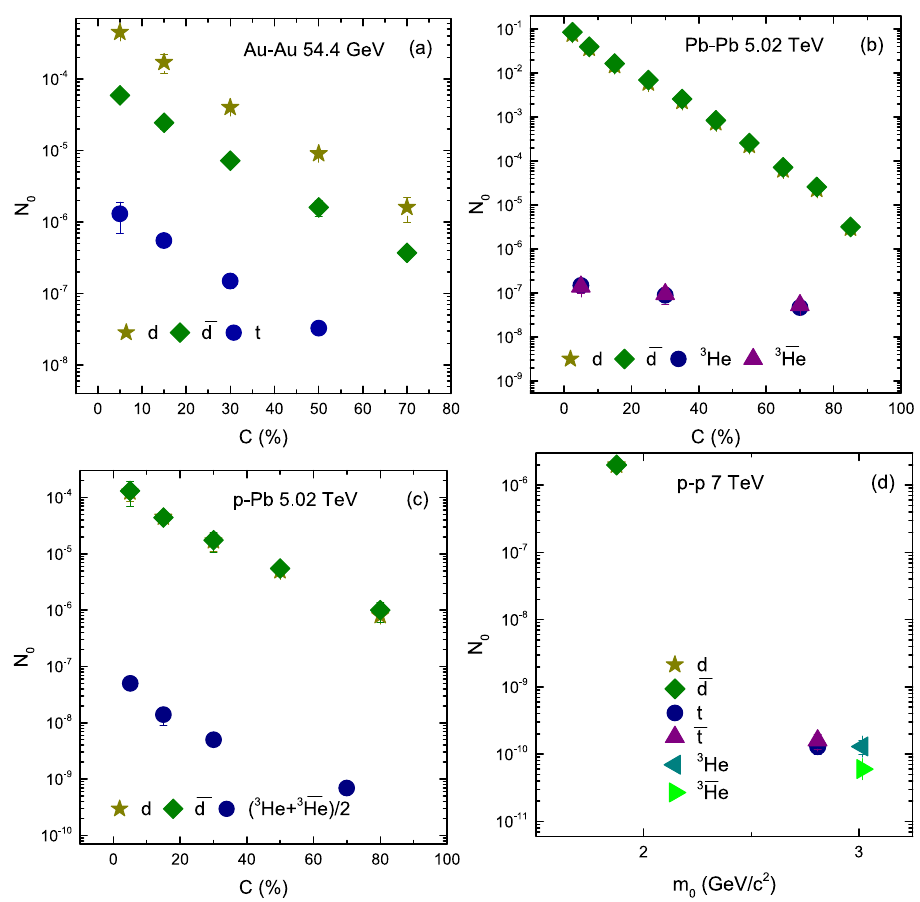
¯ 3 He ¯ d , t , ¯ t , 3 He and or